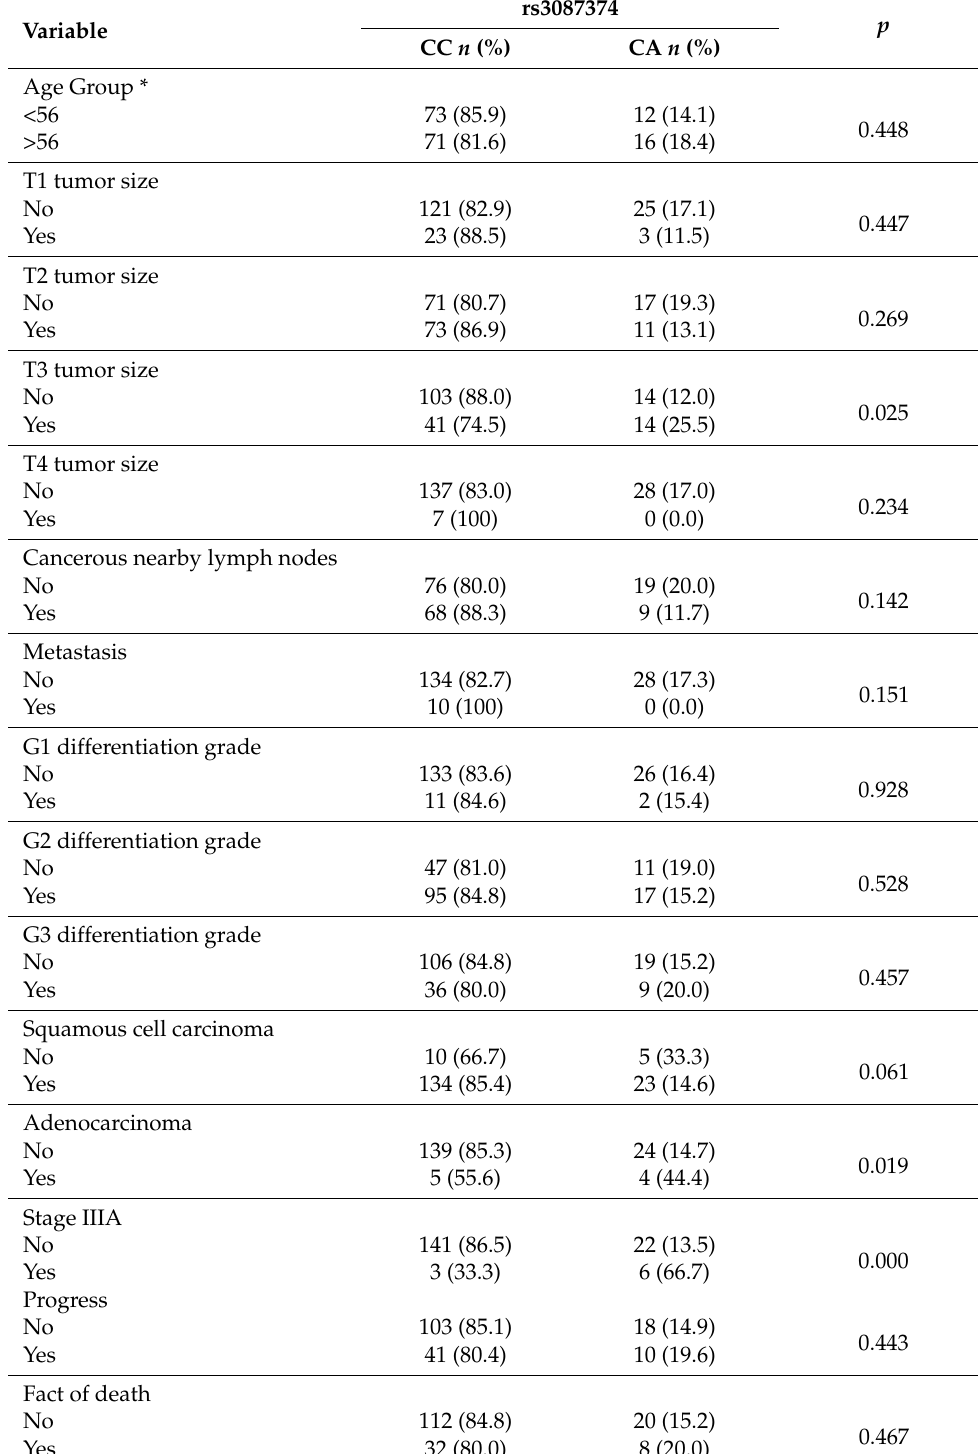
Table 2. POLG gene rs3087374 genotype associations with tumor and clinical